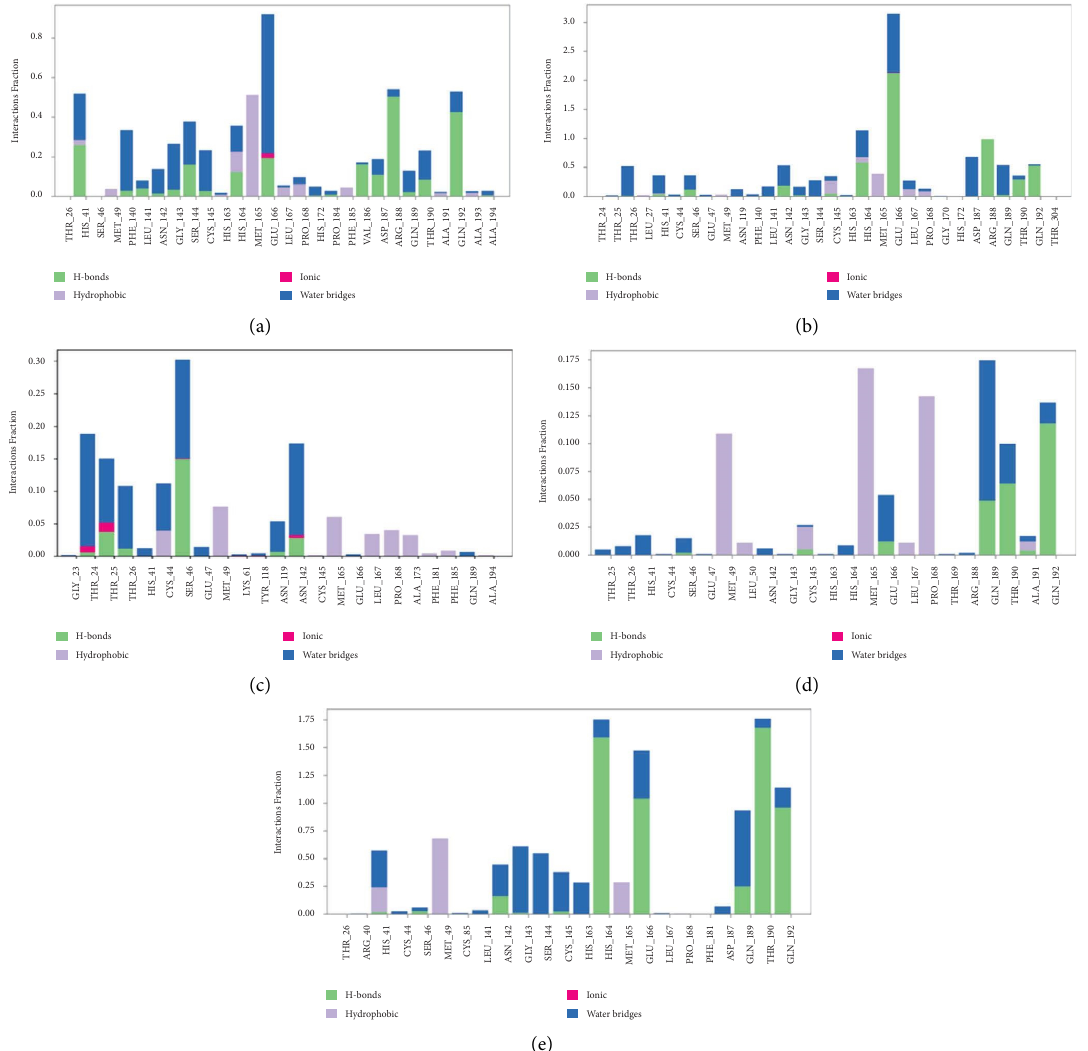
Figure 7: Te simulation interaction of each ligand with the protein target: (a) quercetin (control), (b) procyanidin, (c) oleic acid, (d) methyl linoleic acid, and (e) polar ligands and polar residues. A red bar plot indicates these interactions. Water bridge interactions occur at resi- dues and ligands that interact with hydrogen and are me- diated or mediated by water. A blue bar plot indicates this interaction. Te interaction between each test ligand and the control quercetin ligand is shown in Figure 7. Te x -axis on the plot shows the residues interacting with the ligand, and the y -axis on the plot shows the bond fraction. For example, the 0.3 fraction shows that +30% of these interactions occur during the simulation time. How- ever, in the plot of some ligands, there are several residues whose fraction value is greater than 1, which indicates that these residues have several contacts at once.